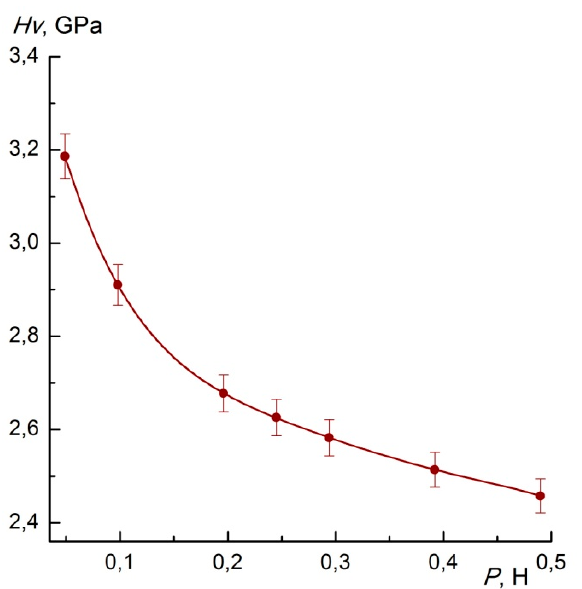
Figure 7. Vickers microhardness of ScF 3 crystals as a function of the load applied on the (111) plane.